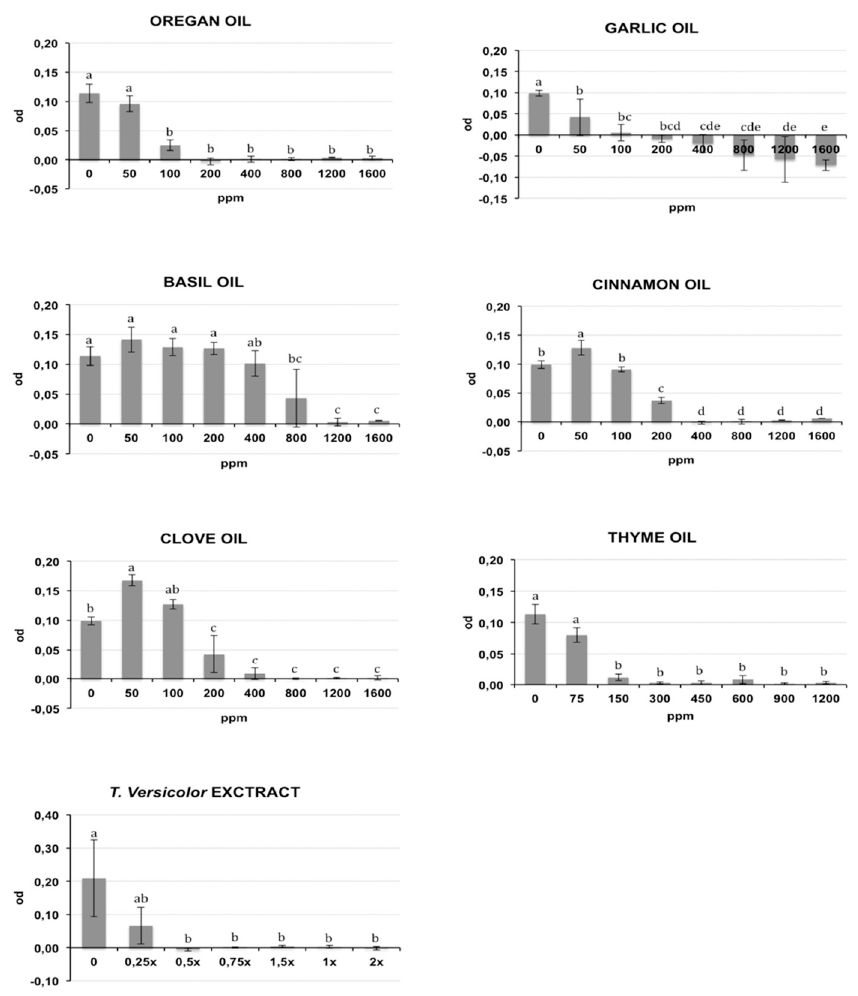
Figure 1. Effects of different concentrations of essential oils on Ralstonia solanacearum (Rs) growth measured as optical density (OD) ( λ = 620 nm). The concentrations are expressed in ppm. Data reported are the means of two repetitions of the experiment. The error bar shows the standard deviation. Significant differences ( p ≤ 0.01) found using the Tukey-Kramer test for multiple comparison are indicated as letters a–f: the same letter within the same graph means no statistical significance between the treatments.